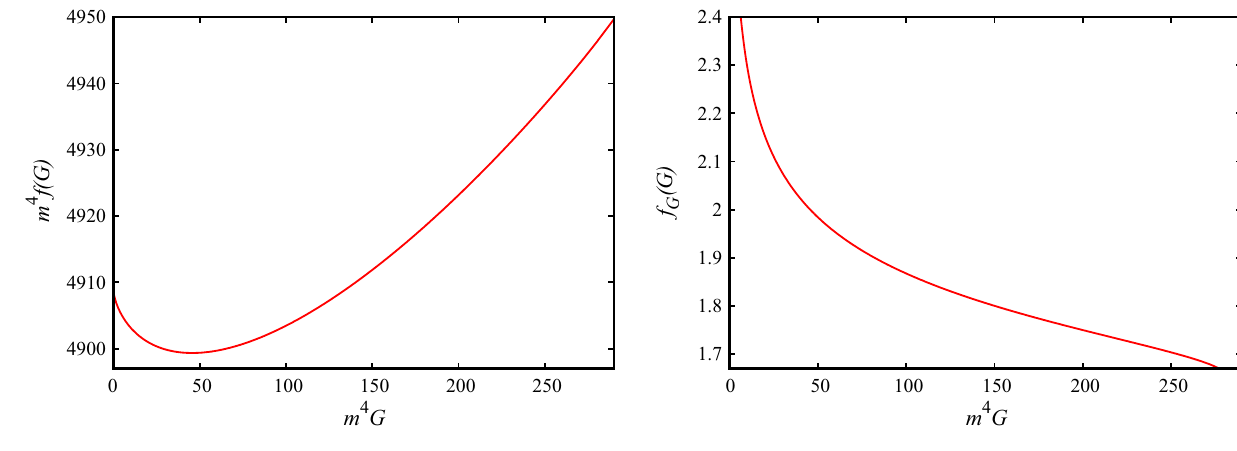
Fig. 3 Graphical representation of the functions f ( G ) and f G ( G ) with c 0 = 1, mc 1 = 1 and q = 0 . 4 m